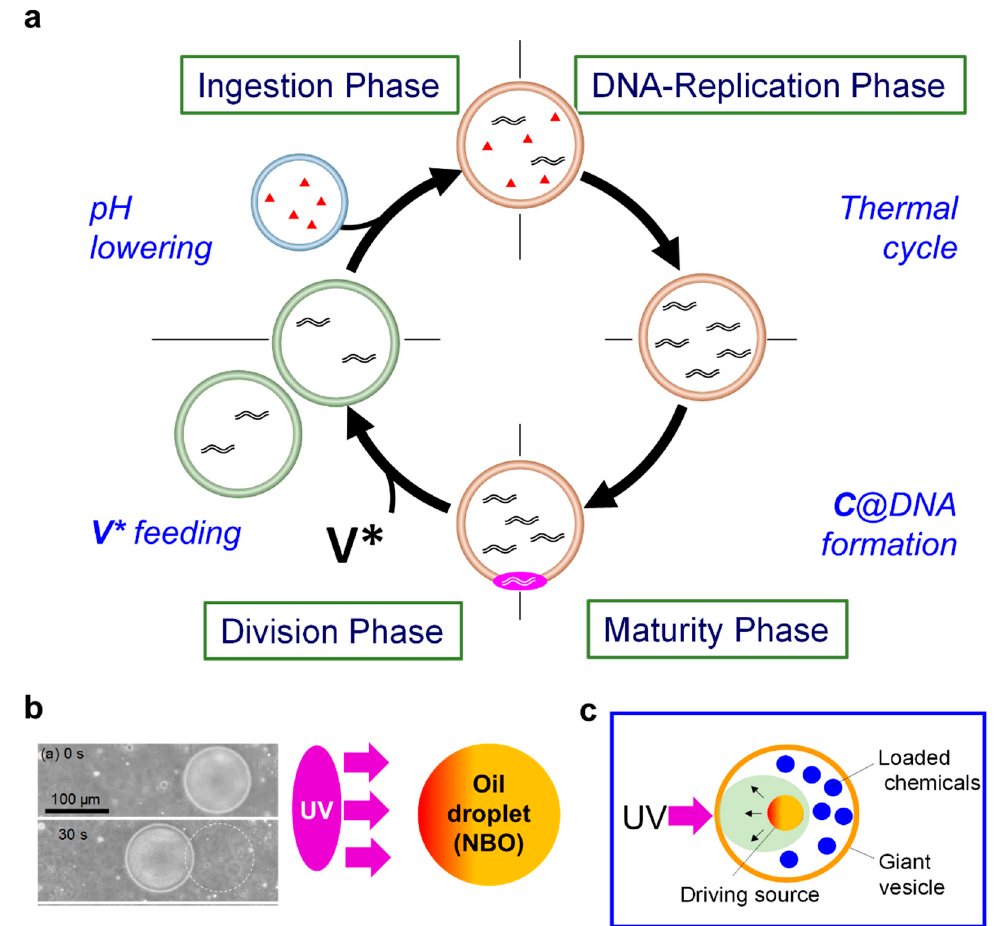
Figure 6. Phototactic movement of an oil droplet ( a ), a GV-based artificial cell ( b ), and a recursive GV-based artificial cell with four cellular phases ( c ).